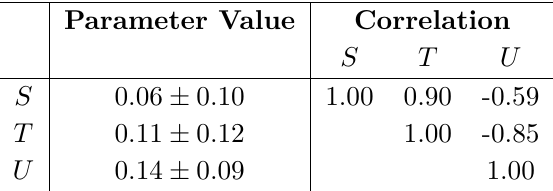
Here R and R are the rotation matrices diagonalizing the squared mass matrices M 2 A Φ